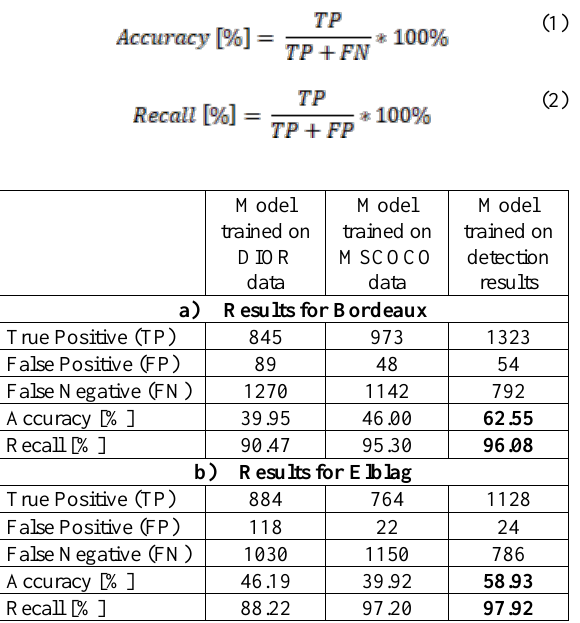
Table 4. Summary of detection results - comparison with the ground truth a) Bordeaux and b)